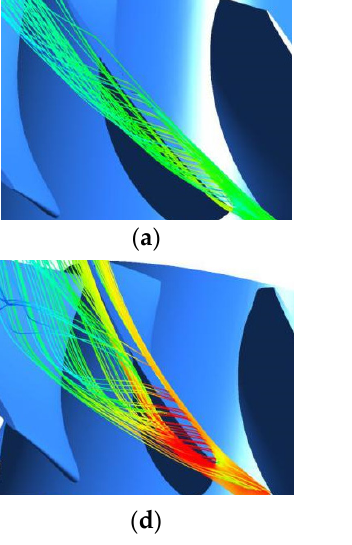
Figure 20. Velocity streamline diagram of the rotor blade tip at different rotating speeds (( a ) 2000rpm; ( b ) 2600 rpm; ( c ) 3200rpm; ( d ) 3600 rpm; ( e ) 4000 rpm; ( f ) legend).